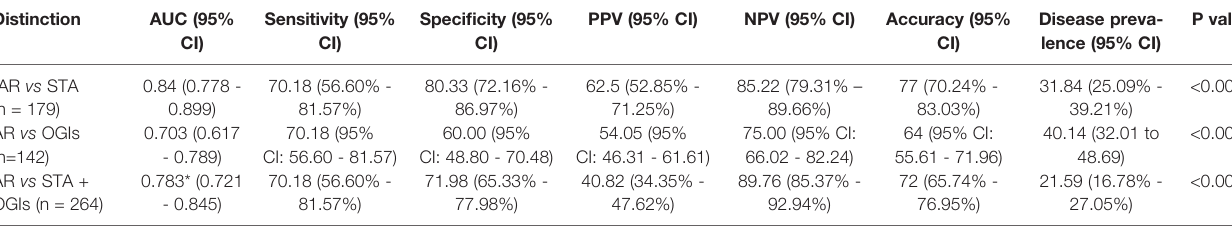
TABLE 3 | Prediction performance of the signature in the validation set by the fi xed cut-off